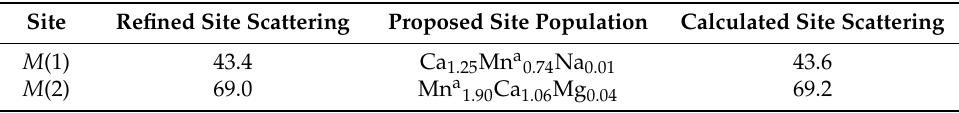
Table 5. Refined site scattering vs. calculated site scattering (in electrons) and proposed site occupancy for M sites in parafiniukite.